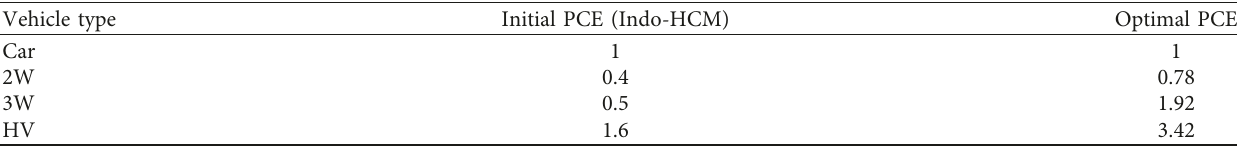
Table 4: Optimal PCE